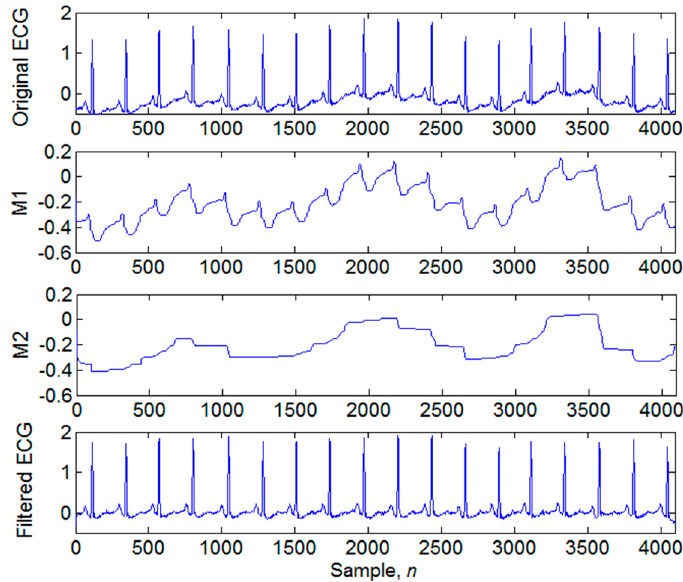
Figure 3. Illustration of removing the low-frequency baseline drift.